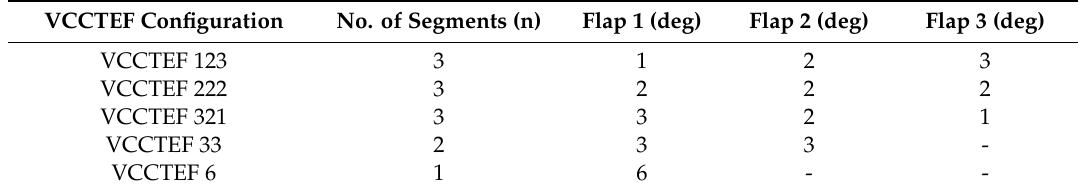
Table 1. Variable camber continuous trailing edge flap (VCCTEF) configurations used in the current study.